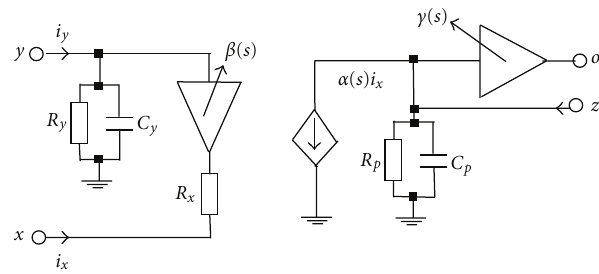
Figure 3: Nonideal equivalent circuit of the CFA includes the parasitic